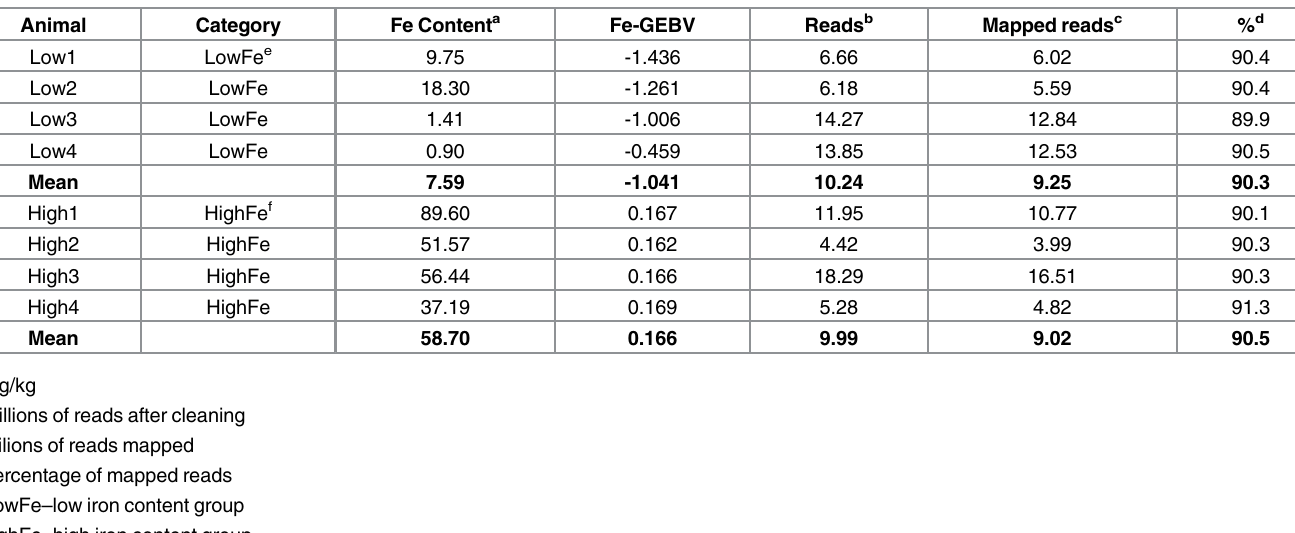
Table 1. Iron content in the Nelore steers Longissimus dorsi muscle, iron content genomic estimated breeding value (Fe-GEBV), number of reads after cleaning, number and percentage of mapped reads.